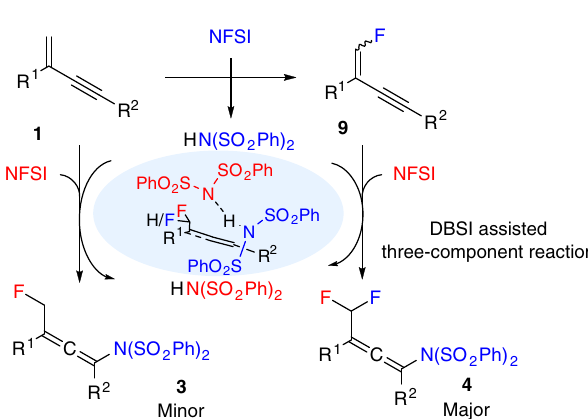
Fig. 7 Proposed reaction mechanism. Dibenzenesulfonimide assisted three-component trifunctionalization of 1,3-enynes.